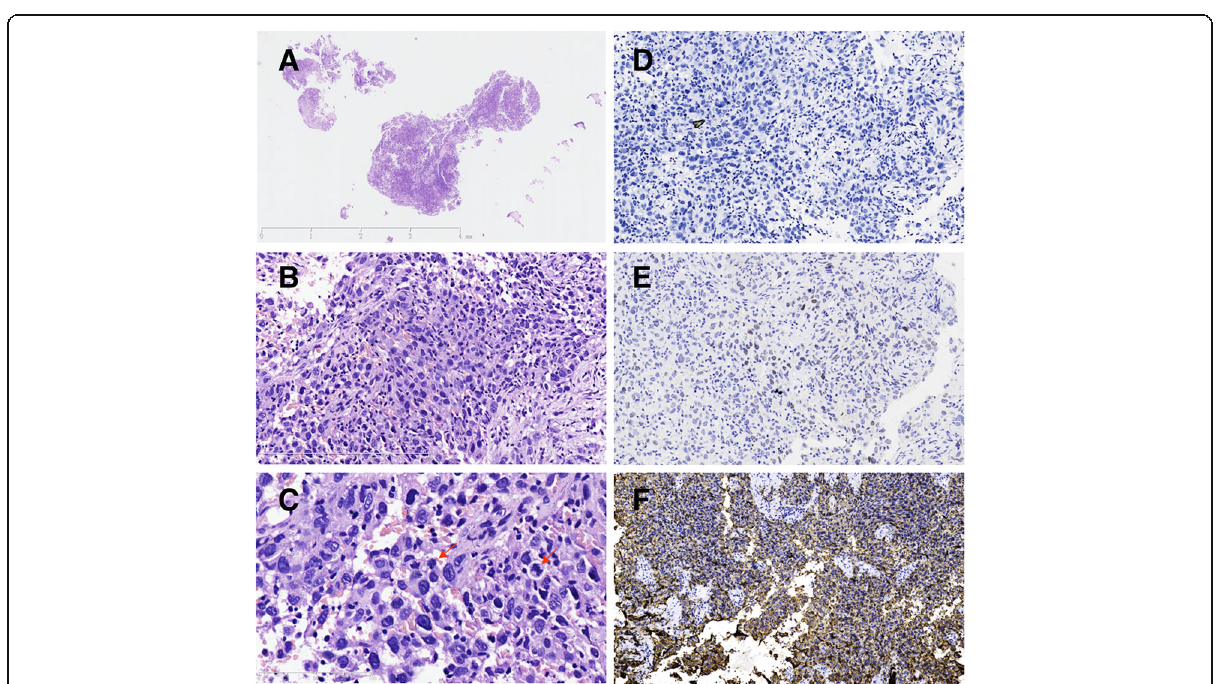
Fig. 2 A low-power view of tumor tissue by transurethral cystoscopy and biopsy ( a ), HE staining reveals that round and polygonal epithelioid-like cells with a sheet or nest-like distribution ( b ), A high-power view shows the obvious cytologic atypia and atypical mitoses of the tumor cells ( c , arrows ). Immunohistochemical staining shows tumor cells are negative for CK ( d ), scattered positive for P63 ( e ), while diffuse positive for CD21 ( f